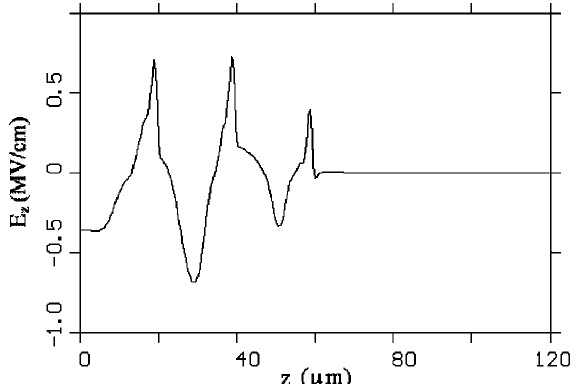
on axial distance z at z